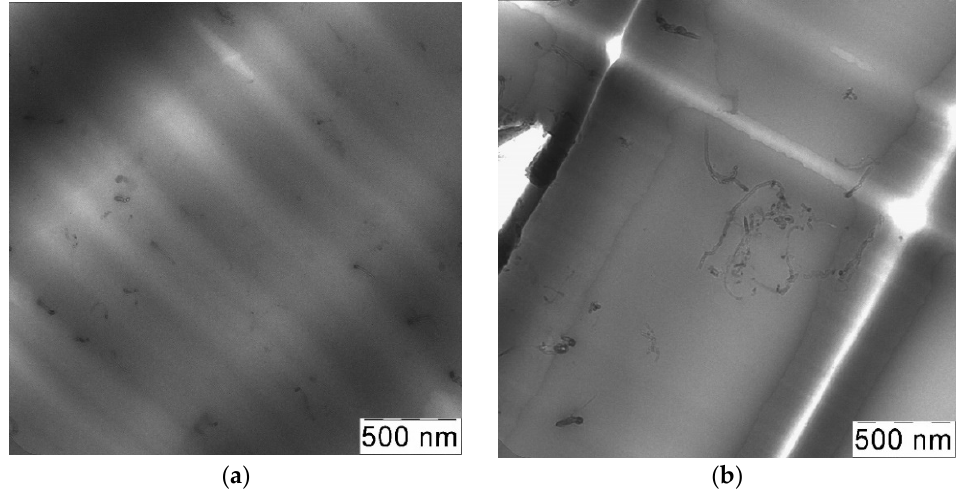
Figure 13. TEM images of composites obtained via SAS with powerful ultrasound treatment: un- treated CNTs ( a ) (experiment № 5) and CNTs processed by RESS ( b ) (experiment № 6).